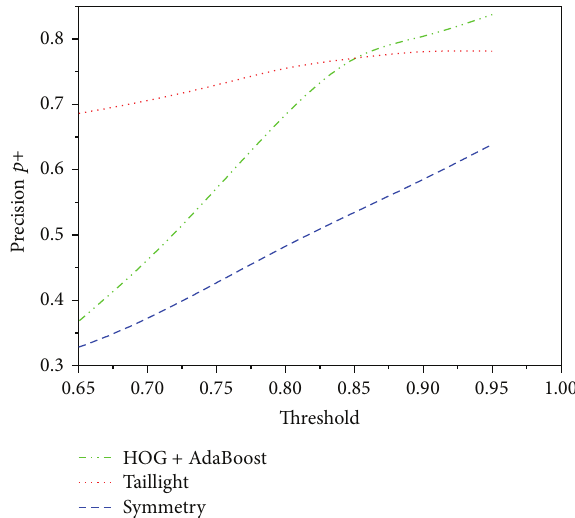
Figure 9: Algorithm precision under various thresholds.